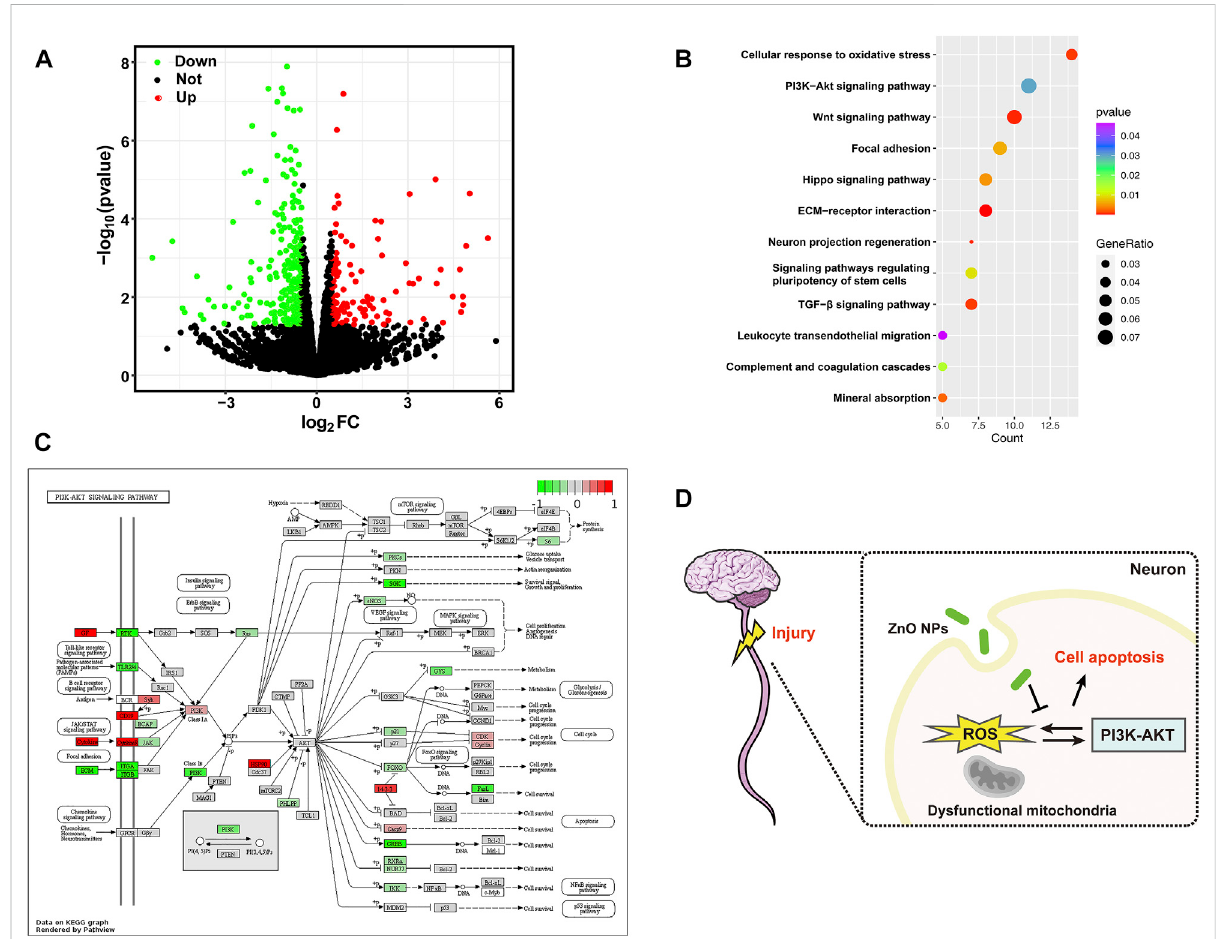
FIGURE 5 (A) Volcanoplotdepictinganoverviewofthedifferentialexpressionofallgenes. (B) Thebubble plotshowssigni fi cantlyenrichedGOtermsand KEGG pathways with p value < 0.05. (C) A visualized DEGs (comparison ZnO treatment group and axotomy group) expression map for PI3K-Akt signalingpathwayfromKEGGdatabase.Redandgreenindicategenesactivatedorsuppressedinthispathway,respectively. (D) Schematicillustration of the study. ZnO NPs protect neuronal cells from apoptosis after SCI by inhibiting ROS levels. The PI3K-Akt pathway may be a key mechanism